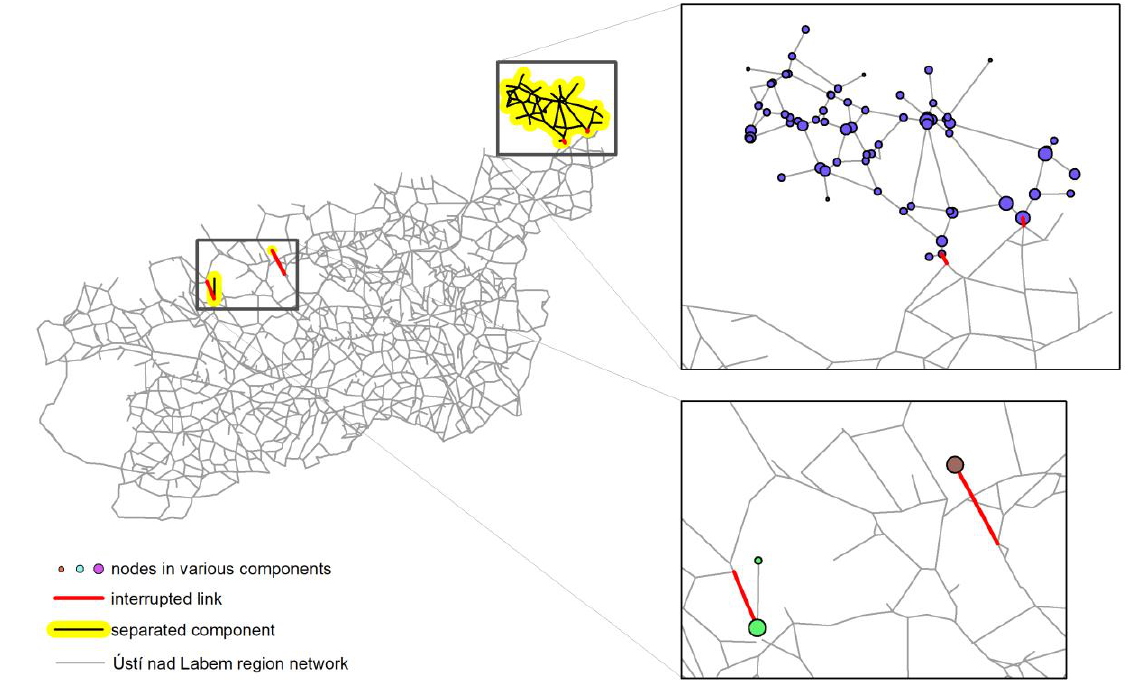
Figure 7. The worst scenario found by ANSA for four concurrently interrupted road links in the Ústí nad Labem region network. 42,712 (4.88%) people cut off from the main network.